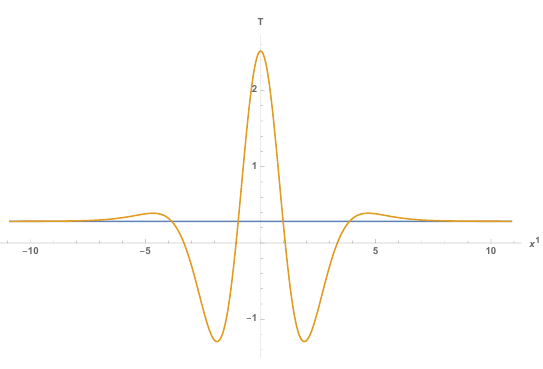
Figure 33 . Tachyon pro(cid:12)le for the excited lump solution of